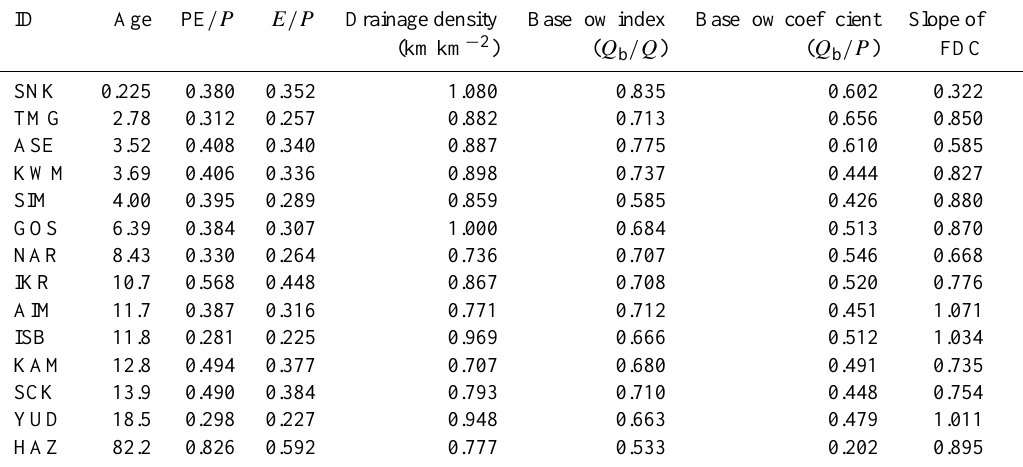
Table 3. Results of hydrometric and landscape analysis of study